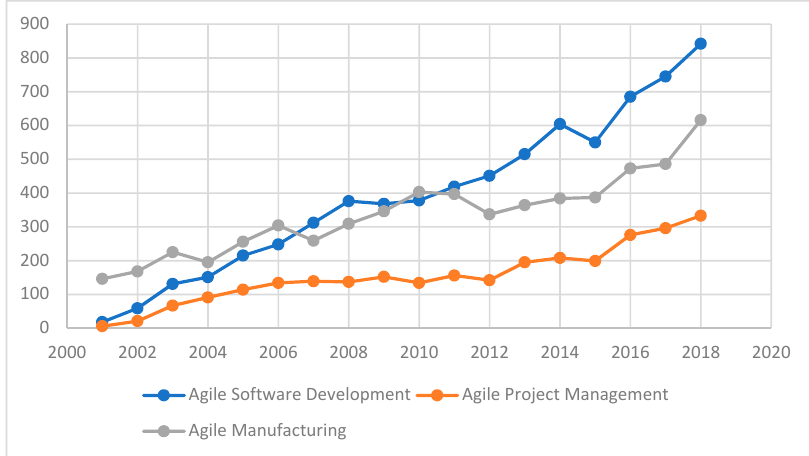
Figure 1. Hits in the Scopus database for selected Agile types (article title, abstract, keywords) in the period 2000–2018.